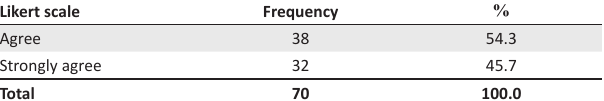
TABLE 3: Engaging citizens in decision-making issues will increase trust levels amongst